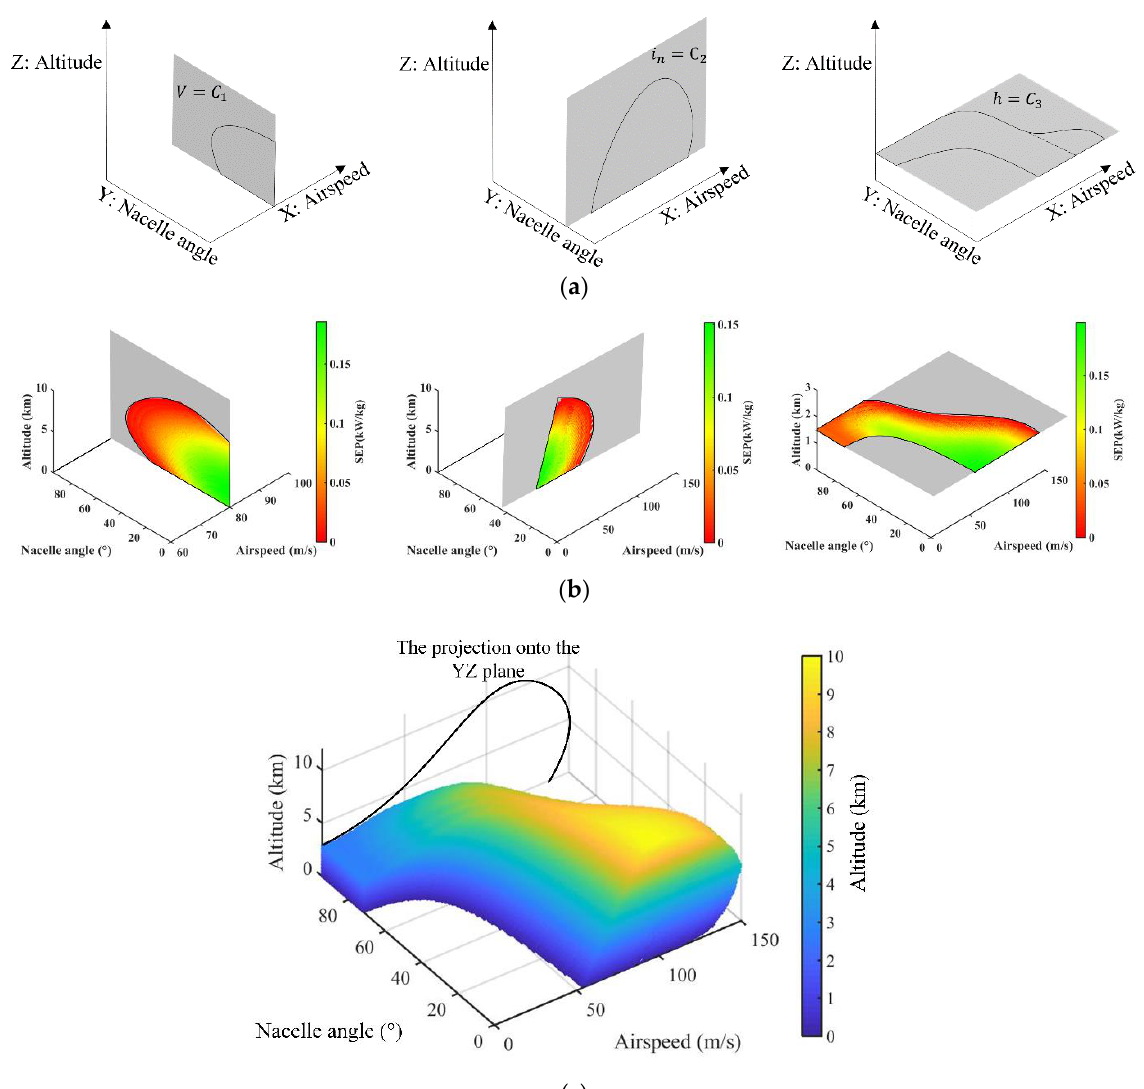
Figure 5. ( a ) Cross-sections of three coordinate values at X, Y, and Z planes; ( b ) cross-sections colored by SEP values at X, Y, and Z planes; and ( c ) the 3D flight envelope projection onto the Y - plane.